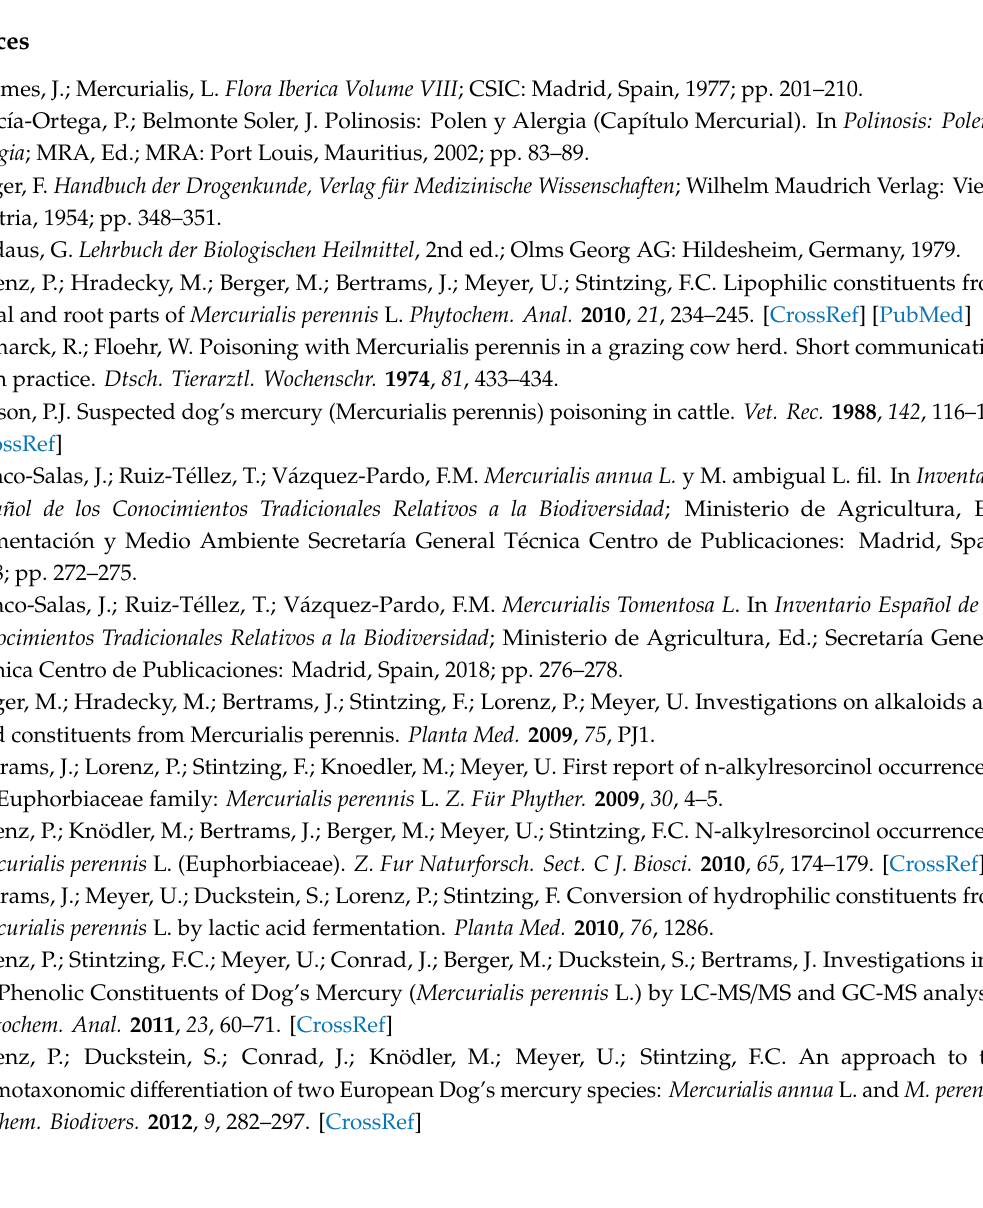
Table S1: Chemical composition of Mercurialis